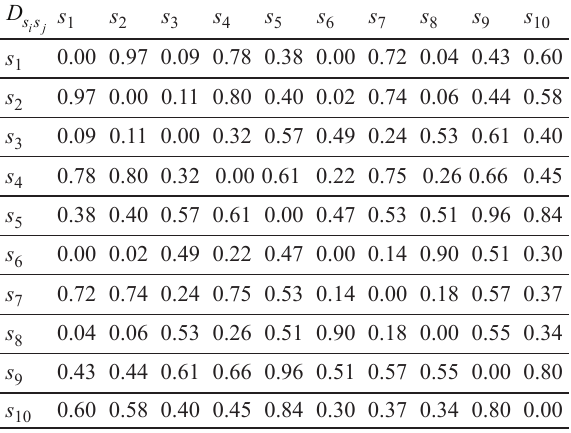
Table 2. Distance between space s i and s j